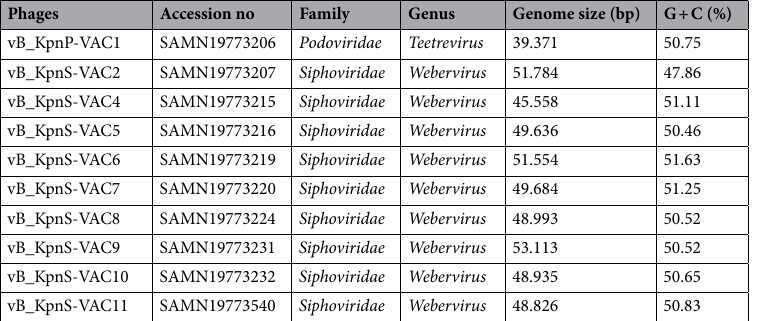
Table 1. Characteristics of the genome sequences of the ten lytic phages under study (BioProject accession number: PRJNA739095; http:// www. ncbi. nlm. nih. gov/ biopr oject/ 739095).